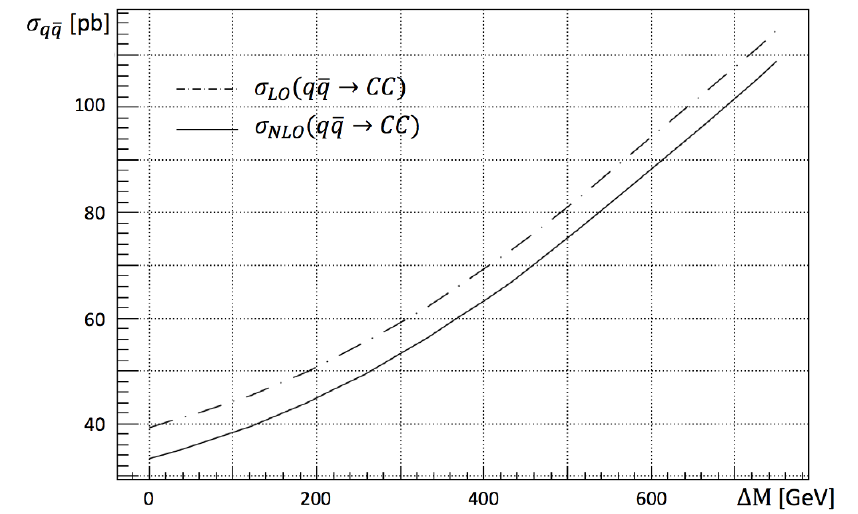
Figure 7 . Total LO and NLO coloron pair production cross-sections as function of quark-coloron mass splitting (cid:1) M = M (cid:0) M (cid:9) . The other input parameters have been set to M = 1 TeV, and (cid:22) = (cid:22) F = M